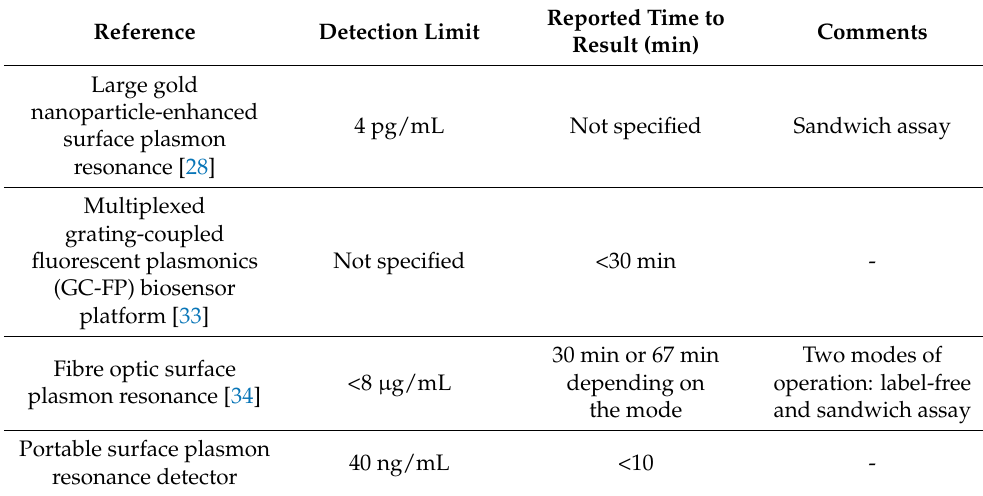
Table 2. Comparison of detection limits between present system and previously reported COVID-19 detection results obtained with SPR.